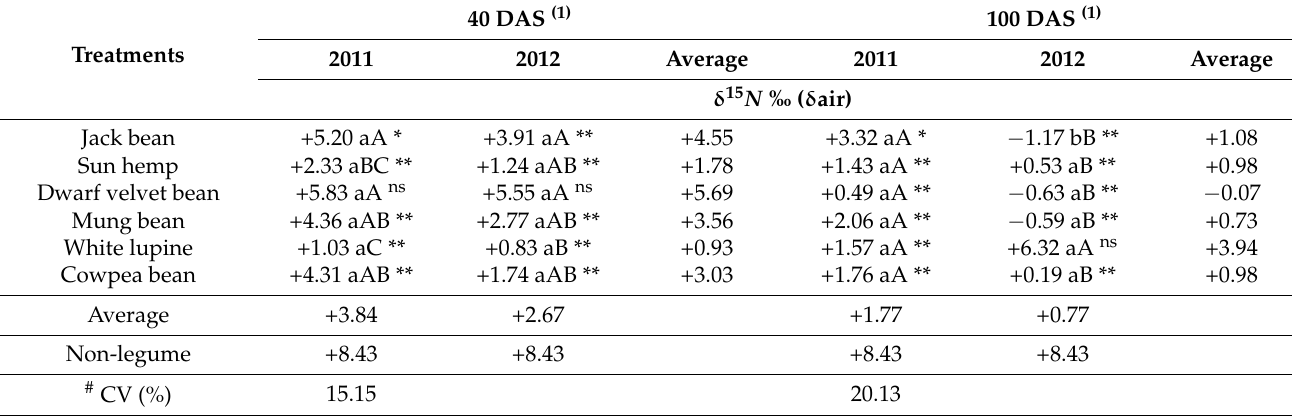
Table 4. 15 N natural abundance of leaves 40 days after sowing (DAS) and aerial part without grain 100 DAS of legumes in intercrop with cherry